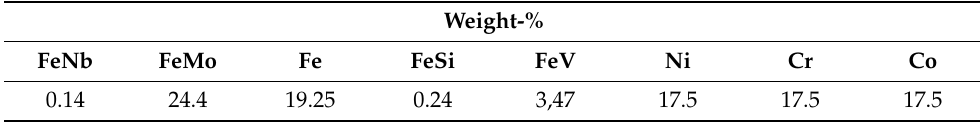
Table 1. Used pre alloys for casting.